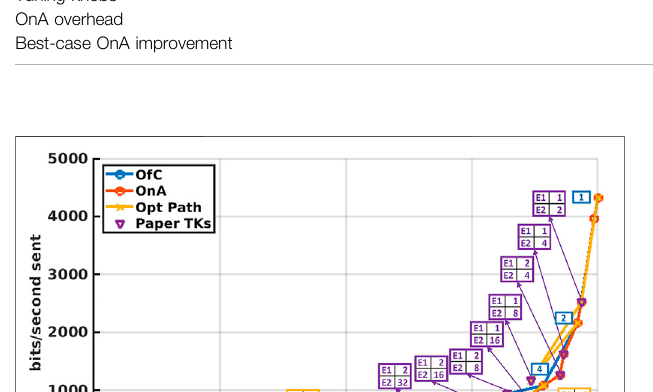
— — Application ECG compression using adaptive decimation and wavelet compression Quality PRD (a measure to express reconstruction errors of compressed signals) Environment PT/QRS: ECG signals have a peak and a fl at part of their curve Tuning knobs Decimation factor: 1, 2, 4, 8, 16, and 32 OnA overhead